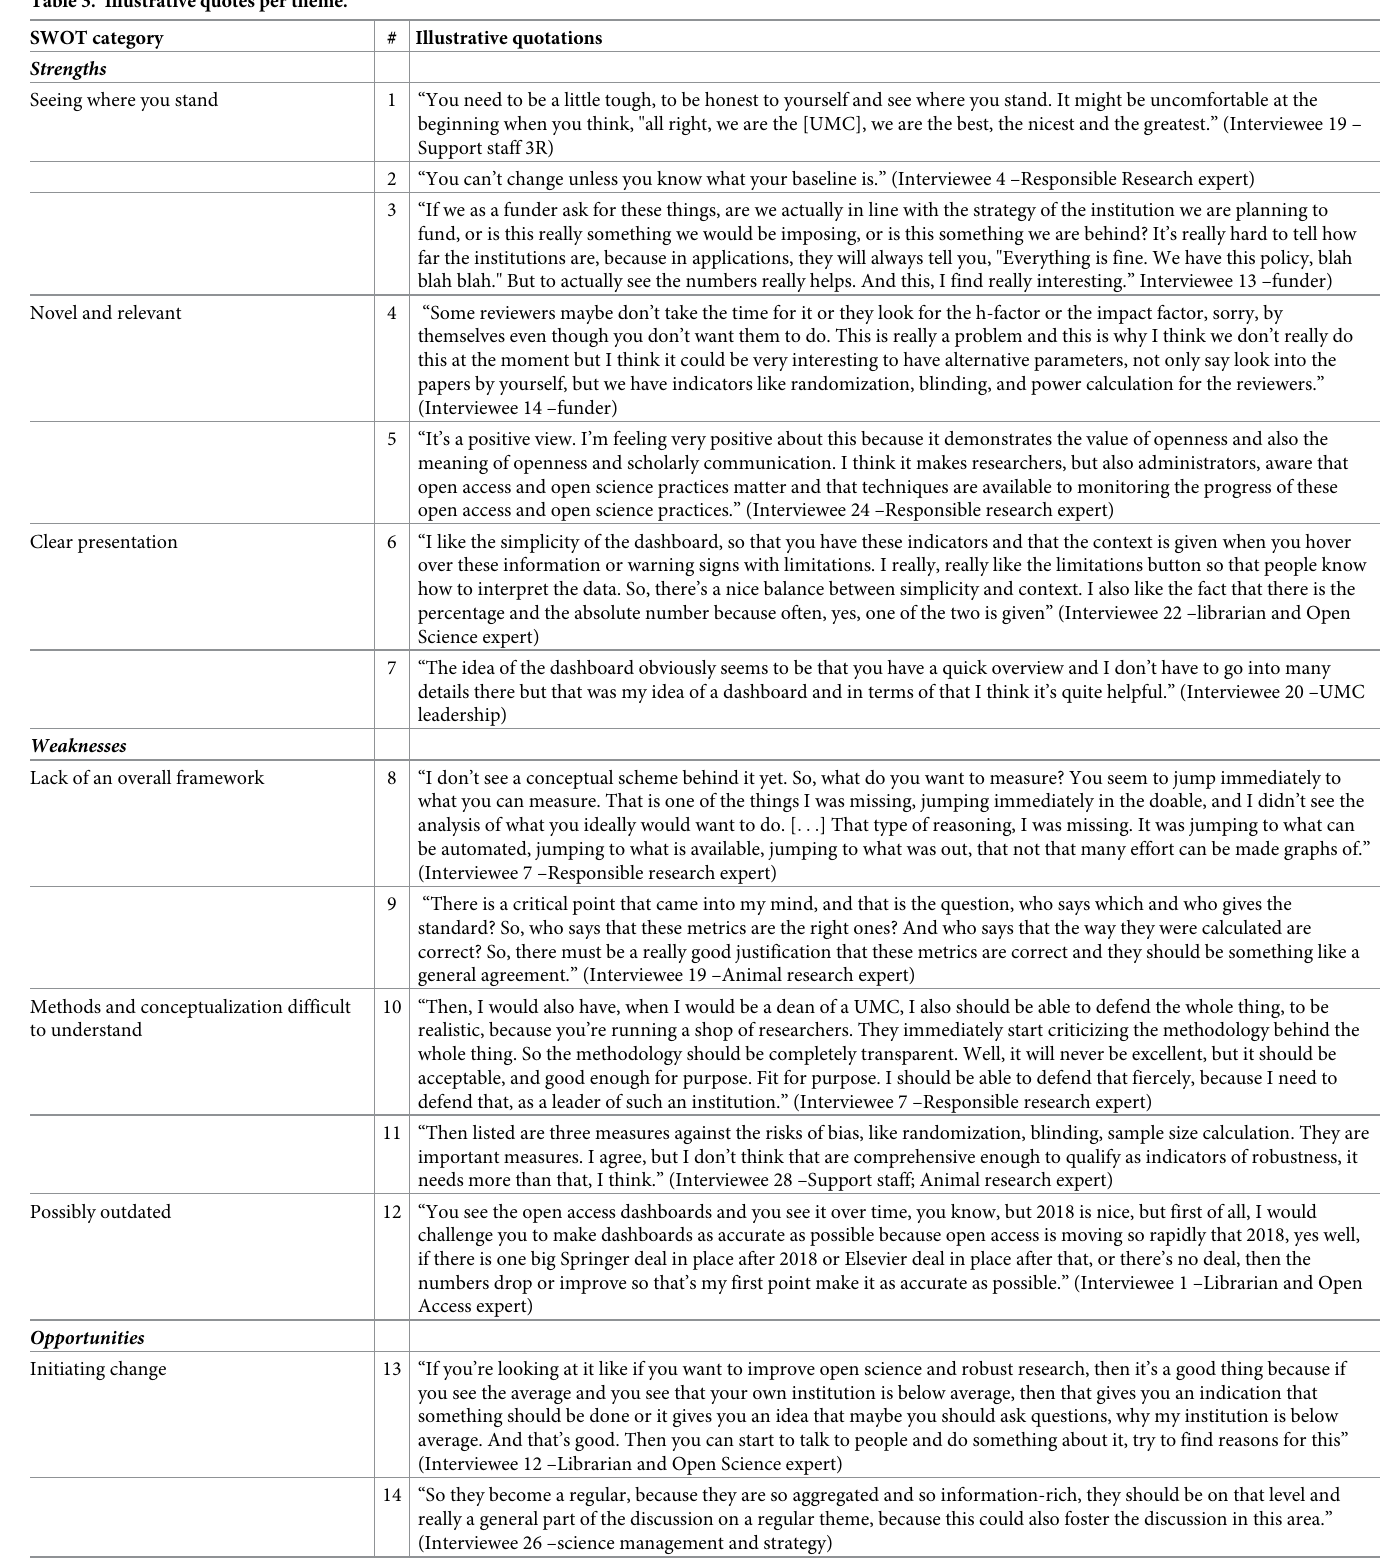
Table 3. Illustrative quotes per